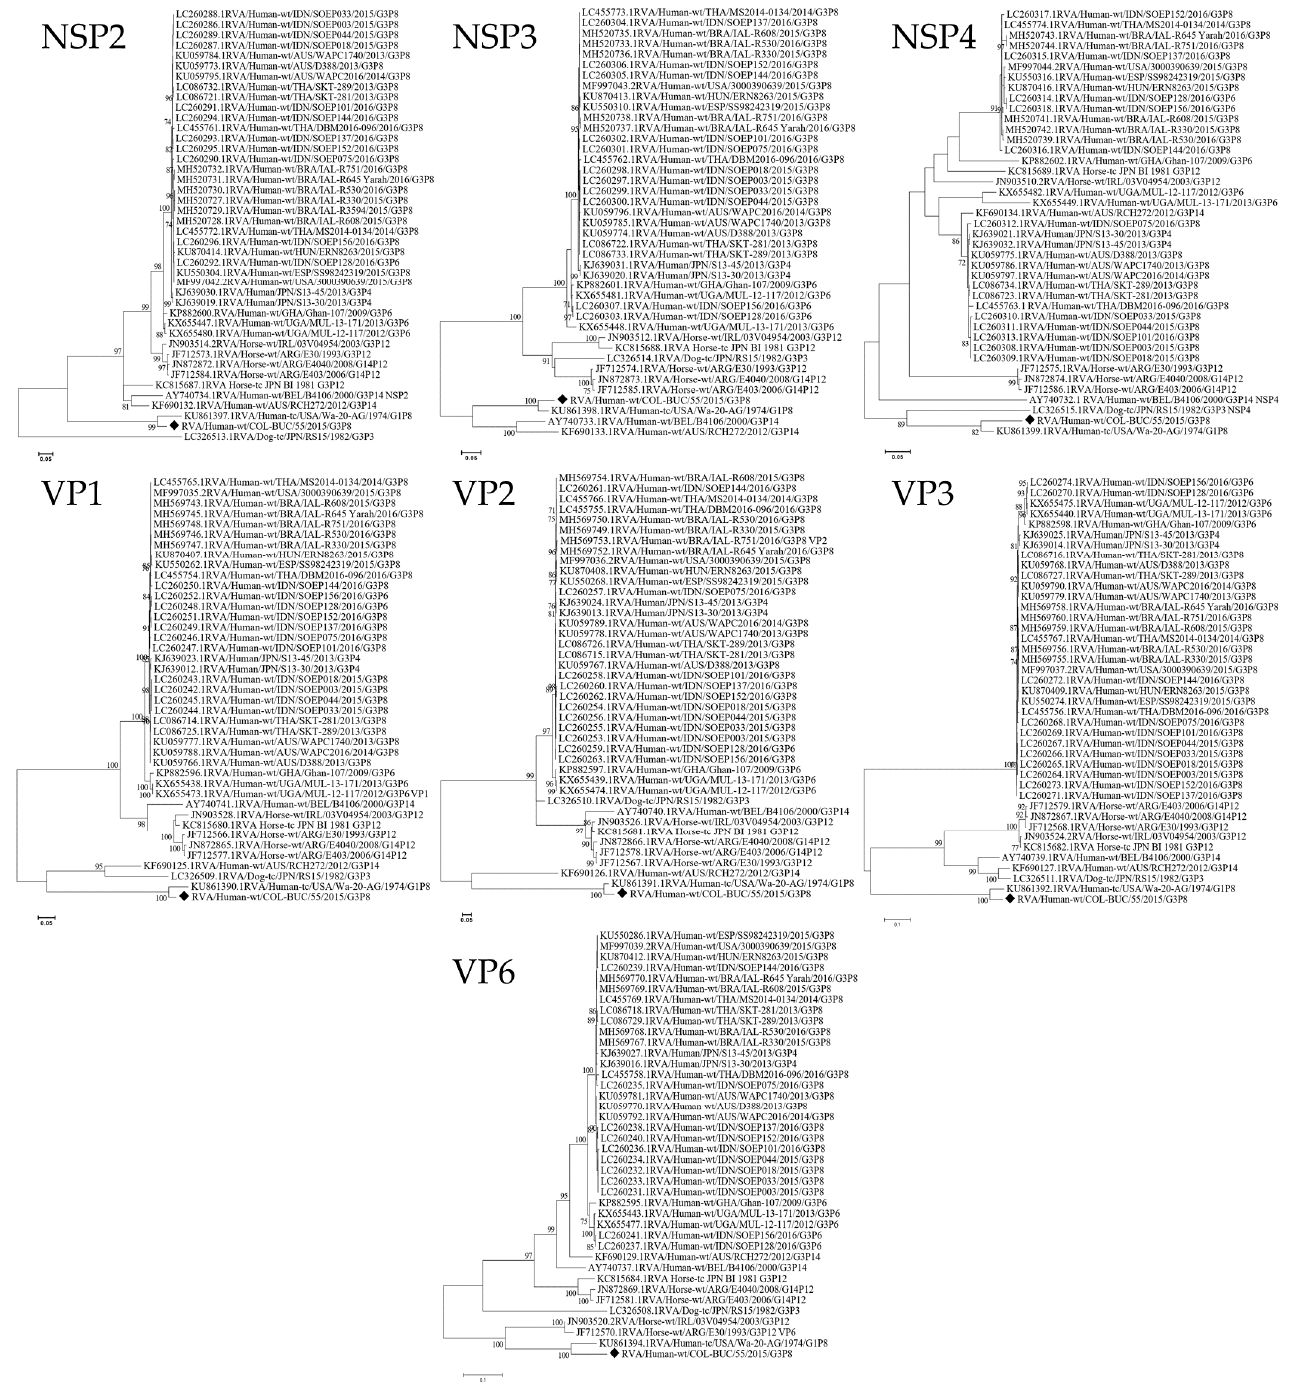
Figure 2. Maximum Likelihood Phylogeny of RVA encoding genome segments of G3P[8] rotaviruses possessing a Wa-like genetic backbone (I1-R1-C1-M1 -N1-T1-E1-H1), compared with other representative human and animal strains from the GenBank database. Bootstrap values lower than 70% are not shown. Scale bars indicate the number of substitutions per nucleotide position. Black Diamonds ( ) indicate the Colombian G3P[8] strain in this study. Evolutionary analyses were conducted in MEGA7.